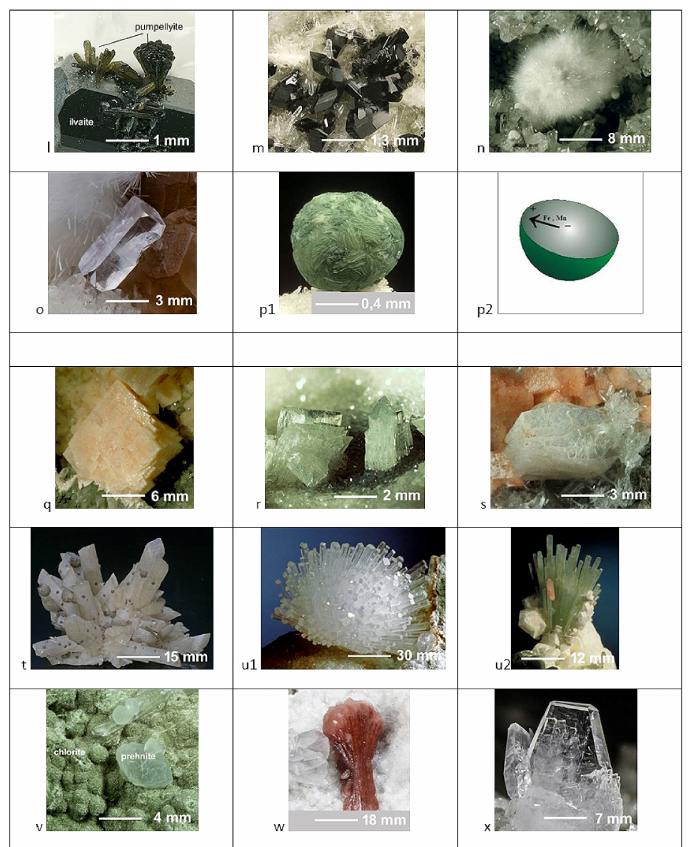
Figure 8. Photographs of secondary minerals from Salsette Island. ( a ) Chalcopyrite; ( b ) Sphalerite and galena as vein filling; ( c ) Pyrite as dodecahedron with gyrolite; ( d ) Hematite; ( e1 ) Quartz, ( e2 ) quartz precipitated on a brownish crust; ( f1 ) Brown calcite I overgrown by quartz, colorless calcite II and yellow chabazite; ( f2 ) Calcite II with flat brown central zone, gyrolite, okenite, and laumontite; ( f3 ) Aragonite; ( g ) Gypsum with apophyllite-(K); ( h ) Andradite (yellow) with prehnite; ( i ) Ilvaite; ( j ) Julgoldite-(Fe 2+ ); ( k1 ) Yellow prehnite; ( k2 ) Casts of green prehnite after laumontite. ( l ) Pumpellyite- (Fe 2+ ) on ilvaite; ( m ) Babingtonite with quartz; ( n ) Okenite; ( o ) Apophyllite-(K) with okenite and quartz; ( p1 ) Gyrolite; ( p2 ) Schematic section through a gyrolite sphere, increasing Fe, Mn content; ( q ) Chabazite-Ca; ( r ) Epistilbite; ( s ) Heulandite-Ca with pink chabazite-Ca; ( t ) Laumontite with gyrolite; ( u1 ) Natrolite; ( u2 ) Green scolecite with red stilbite-Ca and altered apophyllite-K; ( v ) Chlorite with quartz and prehnite; ( w ) Red stilbite-Ca with calcite; ( x )